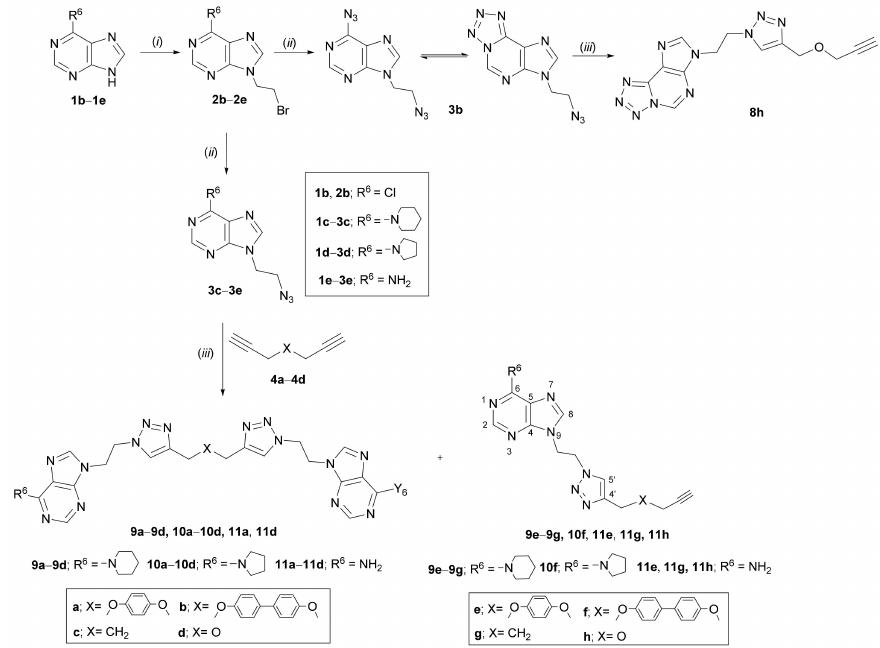
Scheme 2. Reagents and conditions: ( i ) BrCH 2 CH 2 Br, K 2 CO 3 , DMF, rt, 24 h; ( ii ) NaN 3 , acetone, reflux, 24 h; ( iii ) Method A: 1M CuSO 4 , Cu(0), t -BuOH:H 2 O = 1:1, DMF, rt, 120 h; Method B: 1M CuSO4, Cu(0), t -BuOH:H 2 O = 1:1, DMF, 50 ◦ C, US, 45 min, 1000 W; Method C: CuI, DIPEA, AcOH, CH 2 Cl 2 , rt., 72